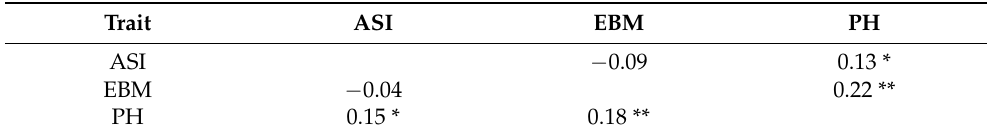
Table 2. Correlation analysis based on BLUP values across three-year environments under drought (WS, above diagonal) and well-watered (WW, under diagonal) regimes. Trait ASI EBM PH ASI − 0.09 0.13 * EBM −